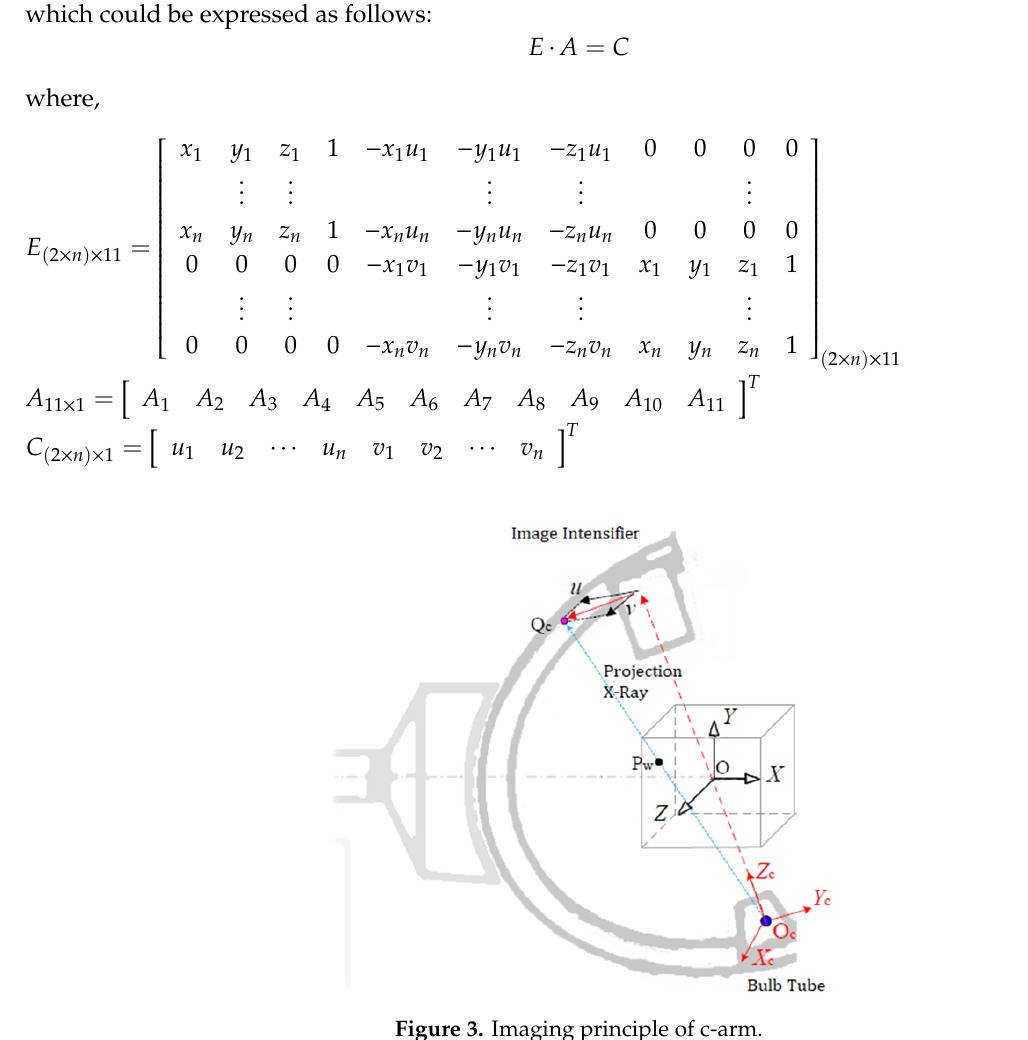
Figure 3. Imaging principle of c-arm.